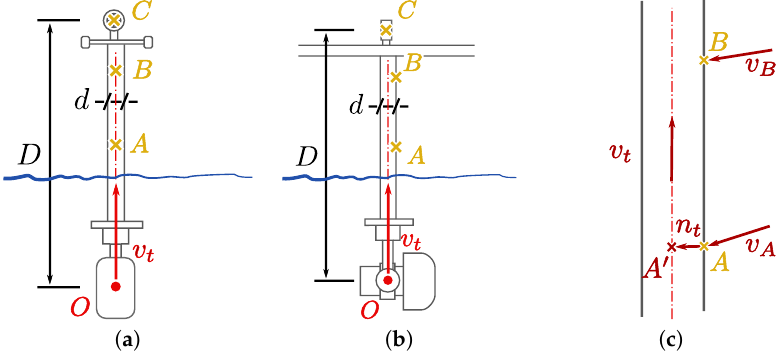
Figure 11. View of the acquisition system with the MSS suspended, ( a ) in the viewing direction of the total station and ( b ) perpendicular to that direction; ( c ) enlarged view of the